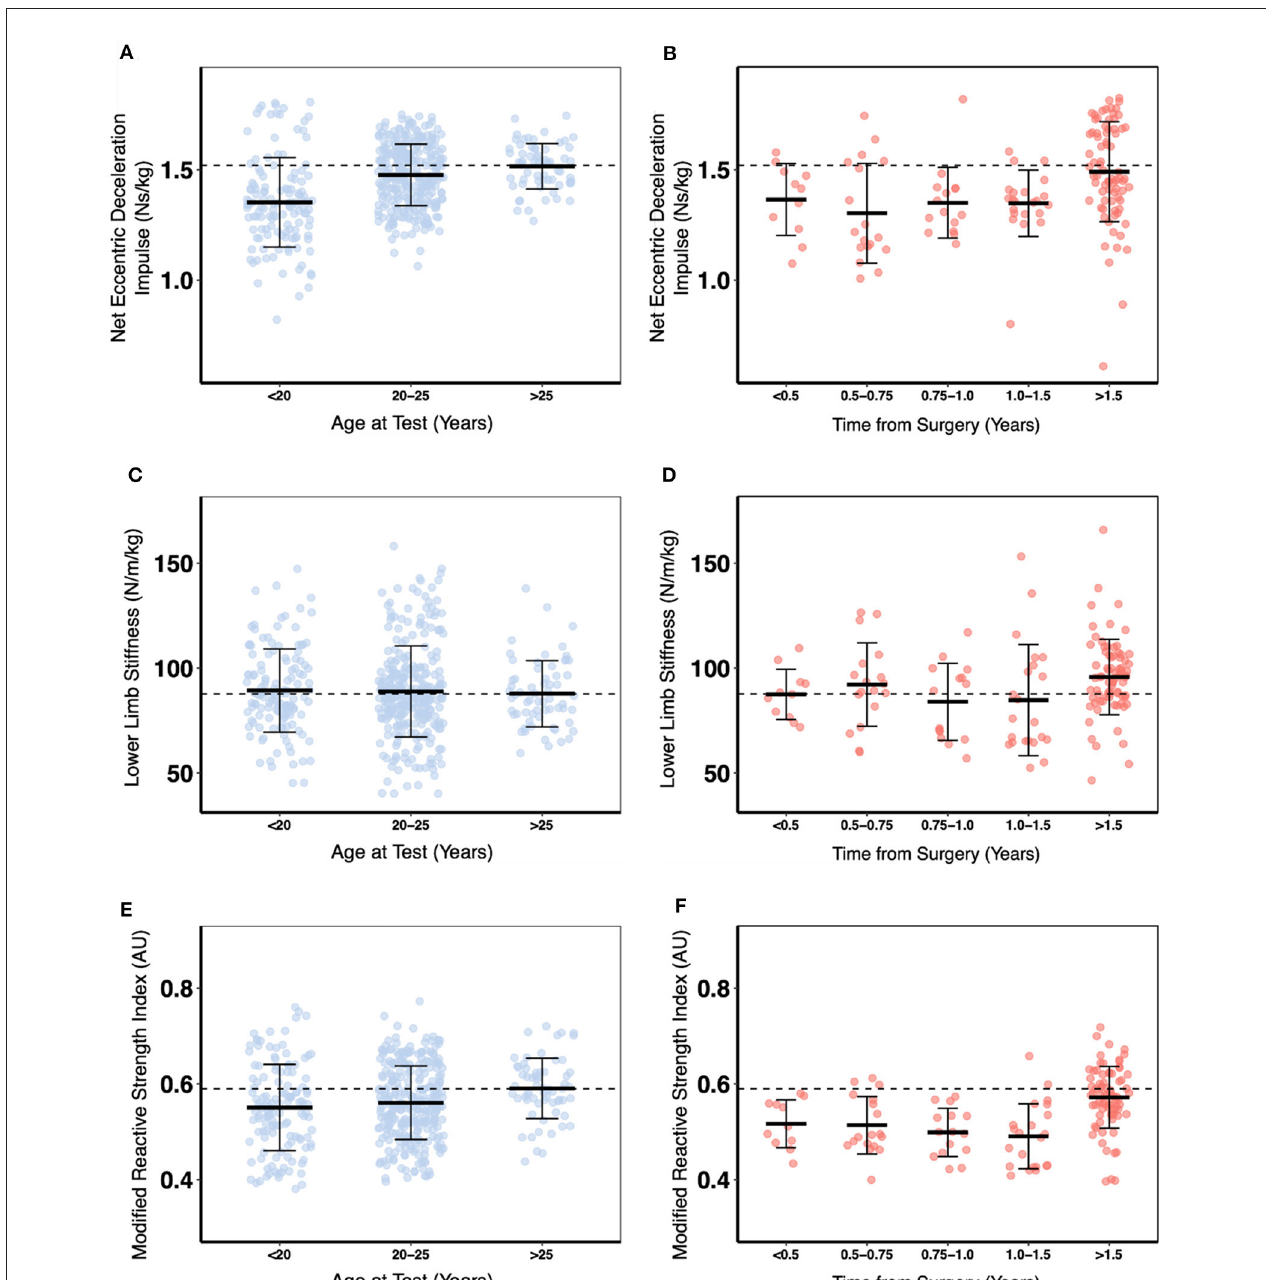
FIGURE 1 | A descriptive comparison of eccentric deceleration phase measures and modified reactive strength index for non-injured controls vs. age and anterior cruciate ligament reconstructed (ACLR) skiers vs. time from surgery. The black dashed line indicates the mean value for non-injured controls > 25 years of age. (A) Net eccentric deceleration impulse control. (B) Net eccentric deceleration impulse ACLR. (C) Lower limb stiffness control. (D) Lower limb stiffness ACLR. (E) Modified reactive strength index control. (F) Modified reactive strength index